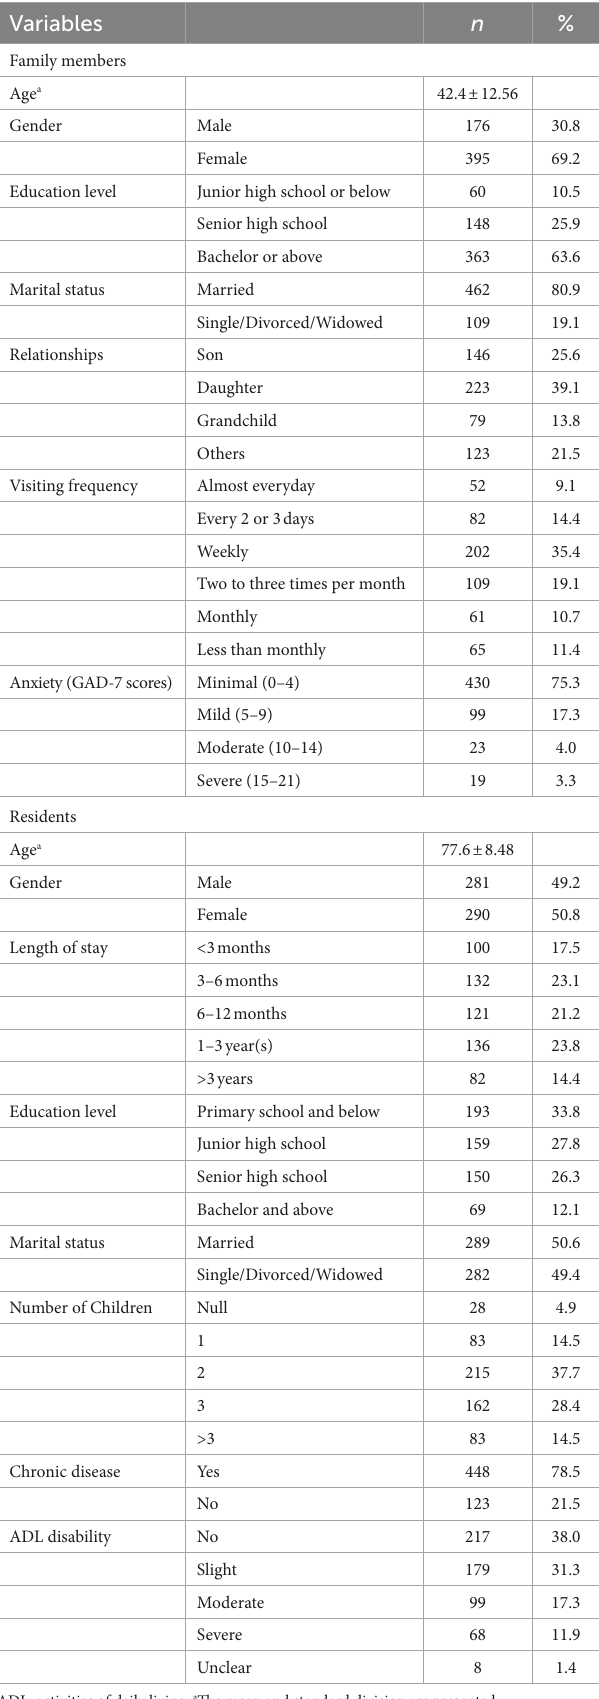
TABLE 1 Basic characteristics of the participants in this study ( N =